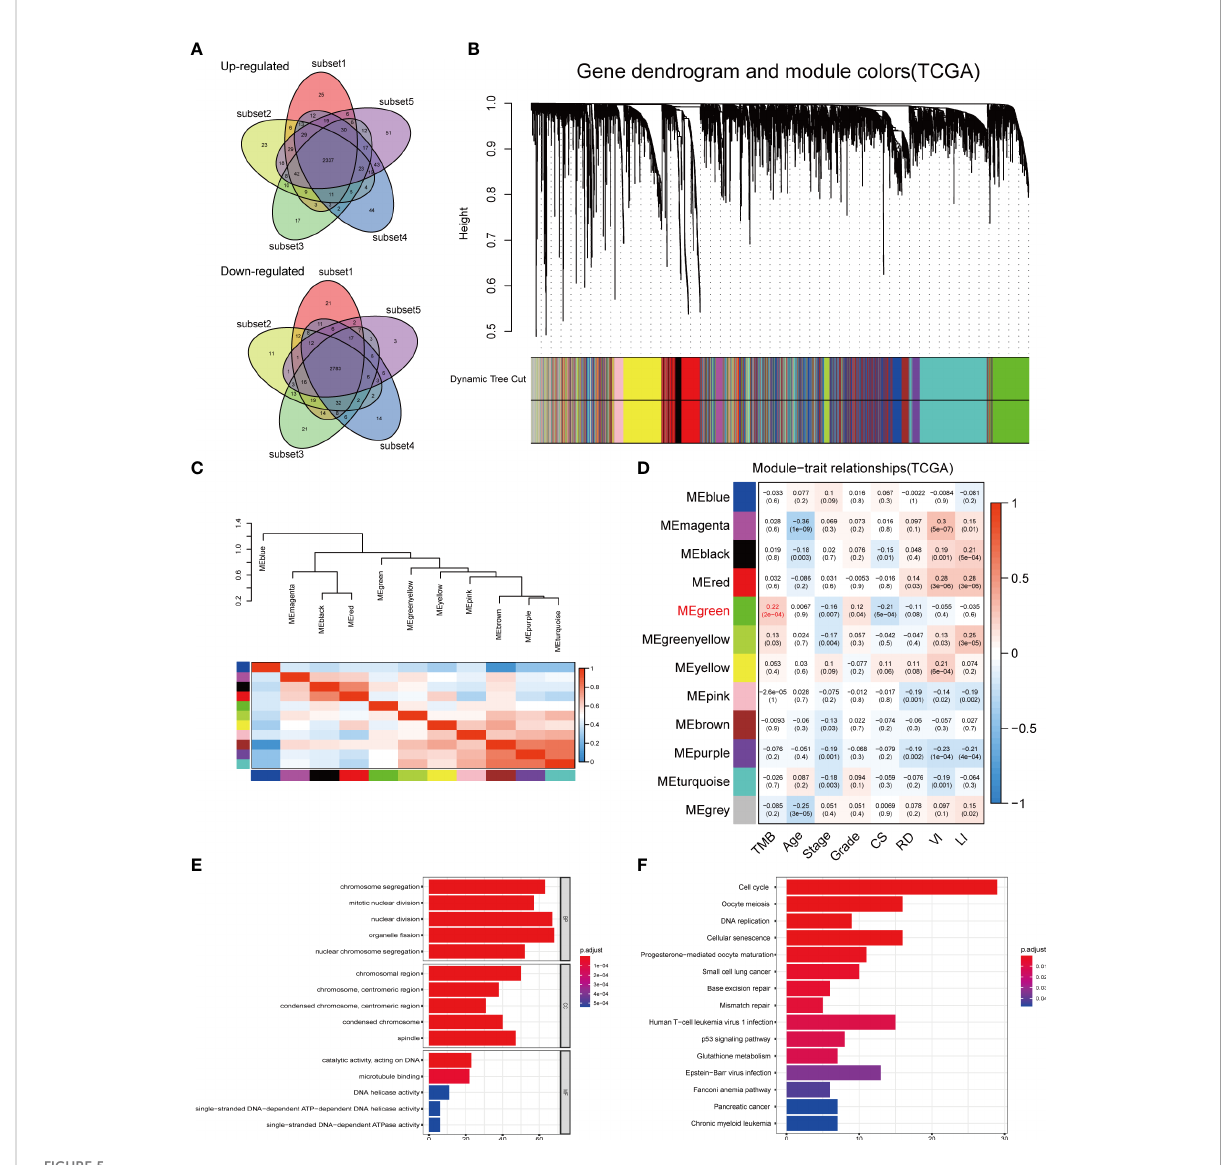
FIGURE 5 DEGs analysis and construction of co-expression modules. (A) Venn diagrams showing the common upregulated genes and common downregulated genes from fi ve subset-based analyses. (B) Clustering dendrograms of DEGs using the dissimilarity measure (1-TOM), with assigned module colors. (C) Visualizing MEs with the hierarchical clustering plot. (D) Correlation between gene modules and clinical traits. Each row corresponded to a module eigengene, and each column to a trait. (E) GO and (F) KEGG enrichment analysis of the green module. DEGs, differentially expressed genes; TOM, topological overlap matrix; MEs, module eigengenes; CS, cancer status; RD, residual disease; VI, venous invasion; LI, lymphatic invasion; GO, Gene Ontology; BP, biological process; CC, cellular component; MF, molecular function; KEGG, Kyoto Encyclopedia of Genes and